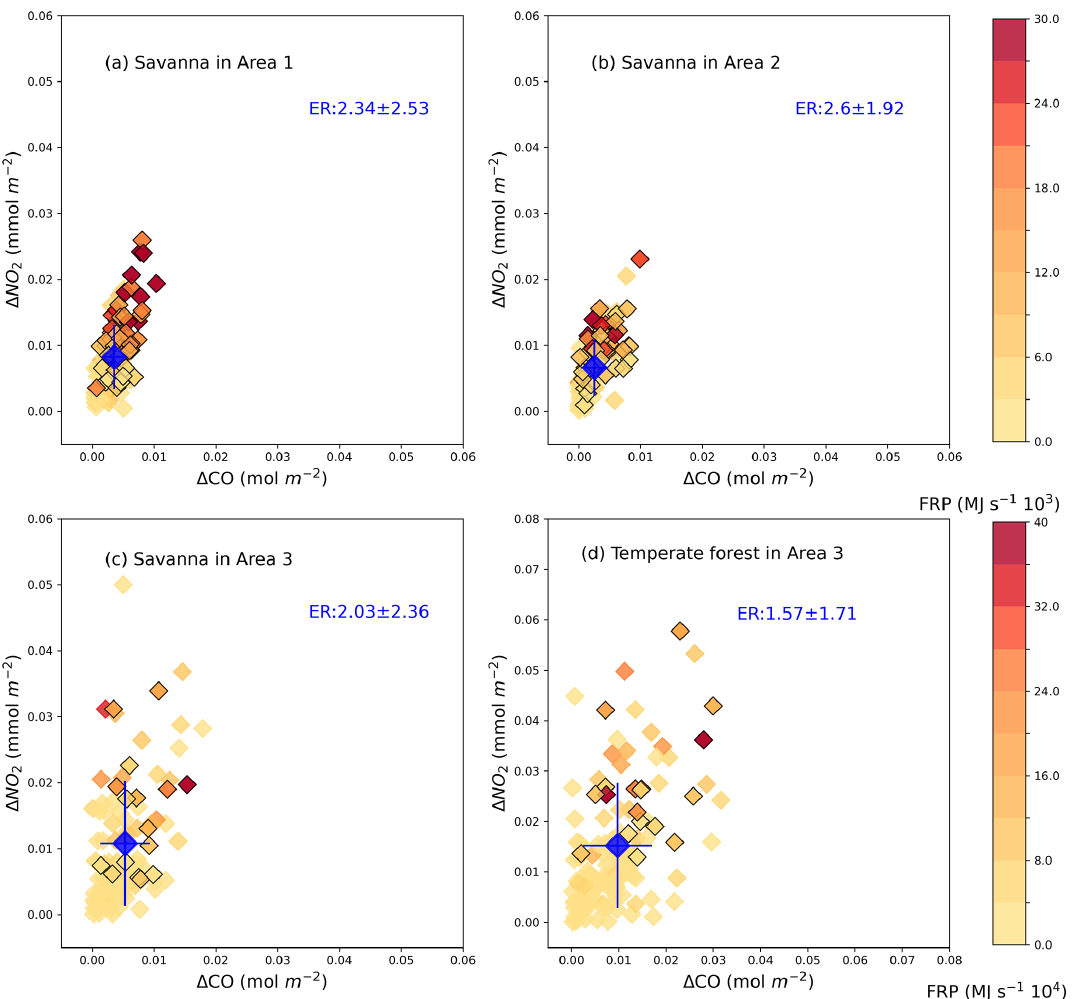
Figure 6. The relationship between daily (cid:49) CO (molm − 2 ) and daily (cid:49) NO 2 (mmolm − 2 ) in savanna regions ( a for Area 1, b for Area 2, and c for Area 3) and temperate forest regions ( d for Area 3 only). The color bars are coded by daily FRP; data points with black edges are the days with high FRP (highlighted periods) in Fig. 4. The blue markers represent the monthly average relationship between (cid:49) CO and (cid:49) NO 2 with day-to-day variabilities represented by the error bars. ER stands for the total emission ratio expressed by overall mean plus and minus 1 standard